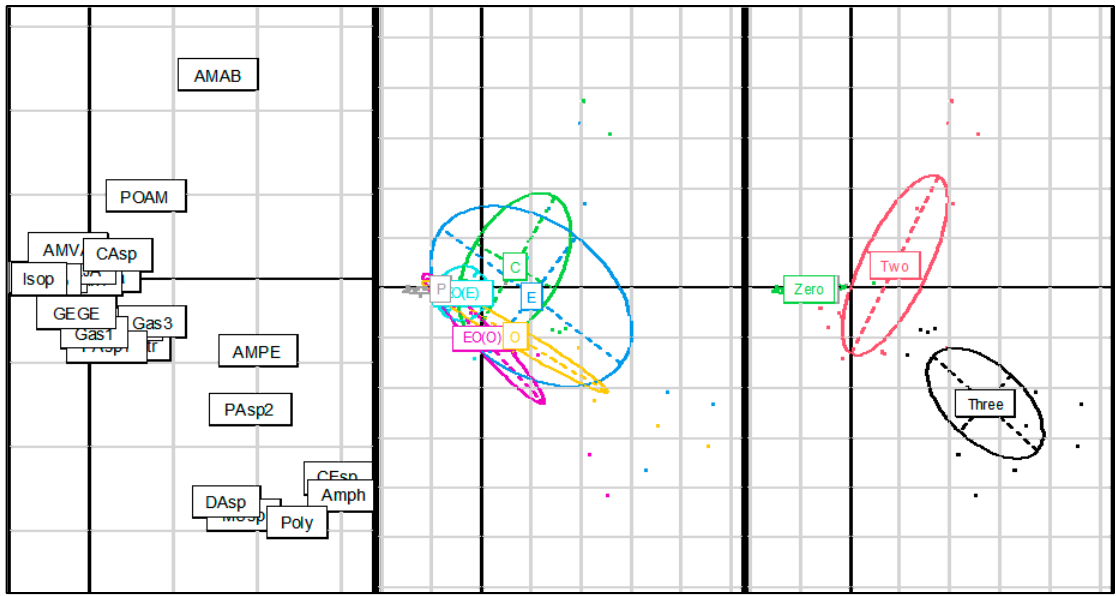
Figure 3. Correspondence analysis of taxa detected across four years of summer season monitoring, including pre-treatment (‘Zero’ July 2012), and after treatment (‘One’ July 2013 (shown behind ‘Zero’), ‘Two’ August 2014, and ‘Three’ August 2015) suction sampling. Panels show taxa ( left ) coded by treatment ( center ) and year ( right ), with all taxa. Treatment abbreviations as in previous figures, taxa abbreviations detailed in Appendix A Tables A1 and A2. Correspondence Analysis (ade4) Factors 1 and 2, Inertia = 39.82%.